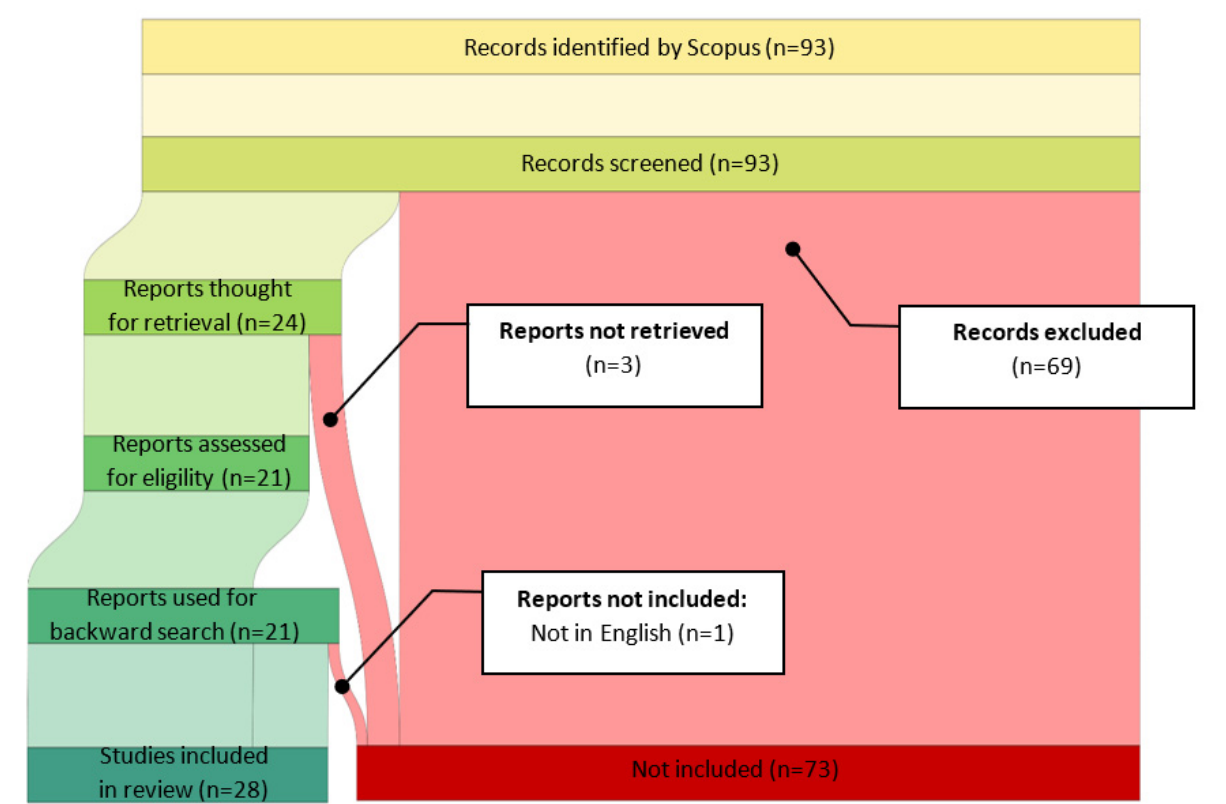
Figure 1. Sankey-based visualization of the PRISMA selection process [25,26]. Figure 1. Sankey ‐ based visualization of the PRISMA selection process [25,26].